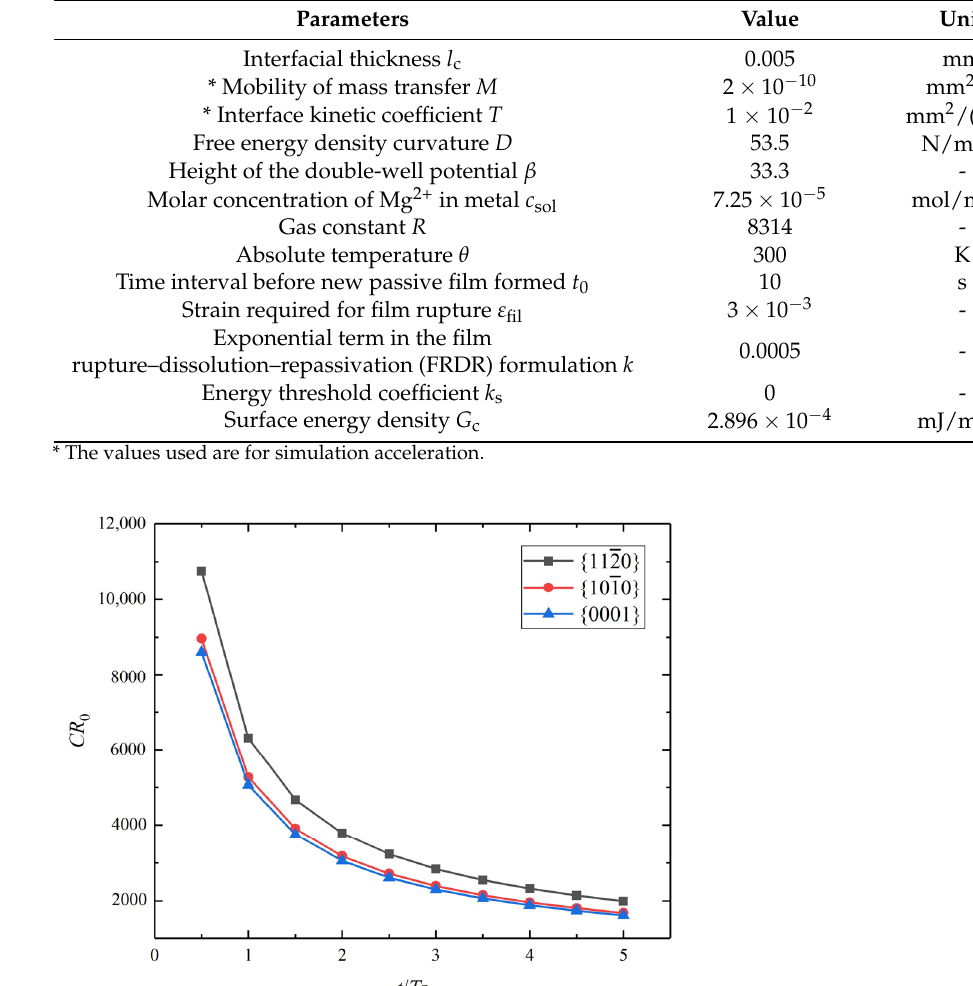
Table 1. Material parameters for the corrosion of Mg in pure water.